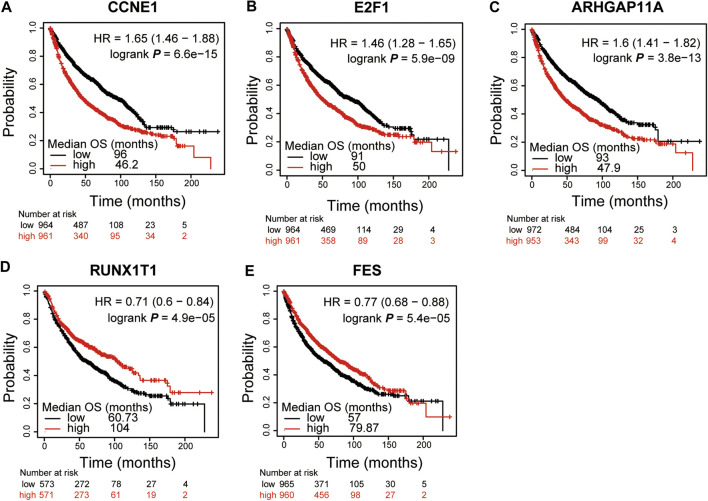

CCNE1, E2F1, ARHGAP11A, RUNX1T1 and FES were significantly associated with patient survival in lung cancer. Kaplan-Meier curves and log-rank test of CCNE1
(A), E2F1
(B) and ARHGAP11A
(C) in lung cancer data sets indicating higher CCNE1, E2F1 and ARHGAP11A expression were associated to poorer patient survival. Kaplan–Meier curves and log-rank test of RUNX1T1
(D) and FES
(E) in lung cancer data sets indicating lower RUNX1T1 and FES expression were associated to poorer patient survival.